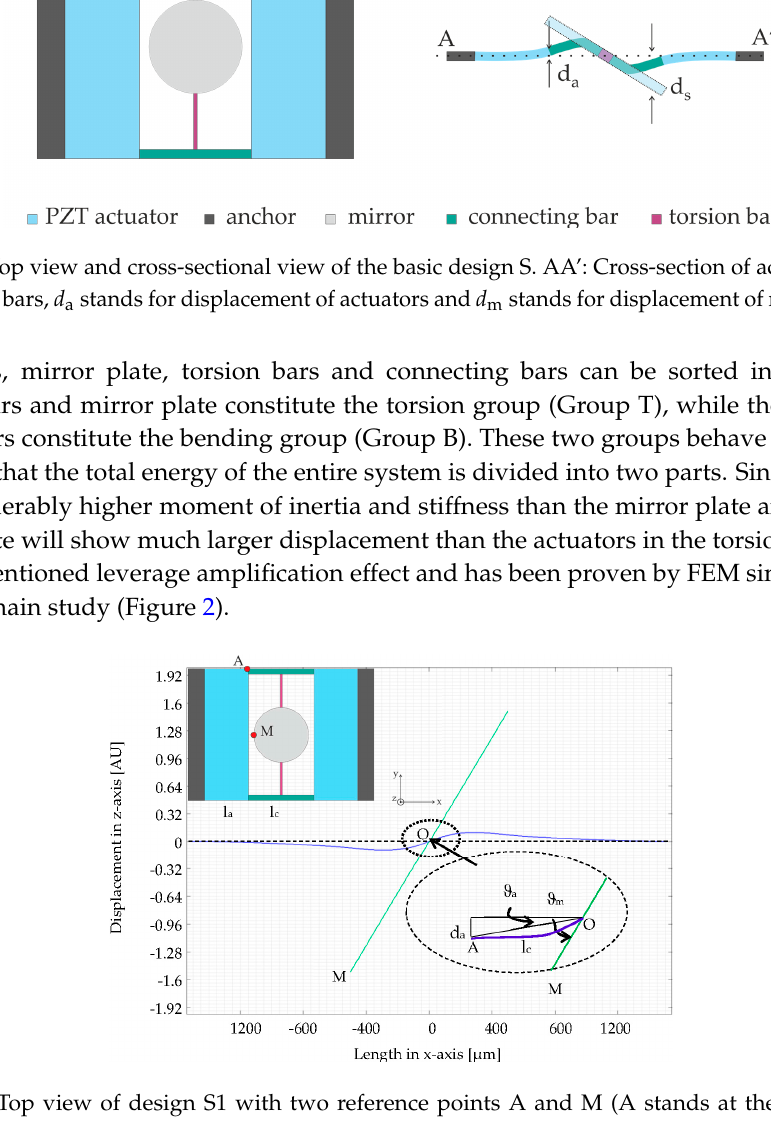
Figure 2. Top view of design S1 with two reference points A and M (A stands at the end of the actuator and M stands on the edge of the micromirror.) and cross-sectional view of a micromirror in torsional mode, which is calculated by finite element method (FEM) simulations: Deflected actuators and connecting bars (blue) and the torsional mirror plate (green) (O: Center of the mirror plate; l a : Length of the actuators; l c : Length of the connecting bars; ϑ a : Angle of actuators and ϑ m : Angle of mirror